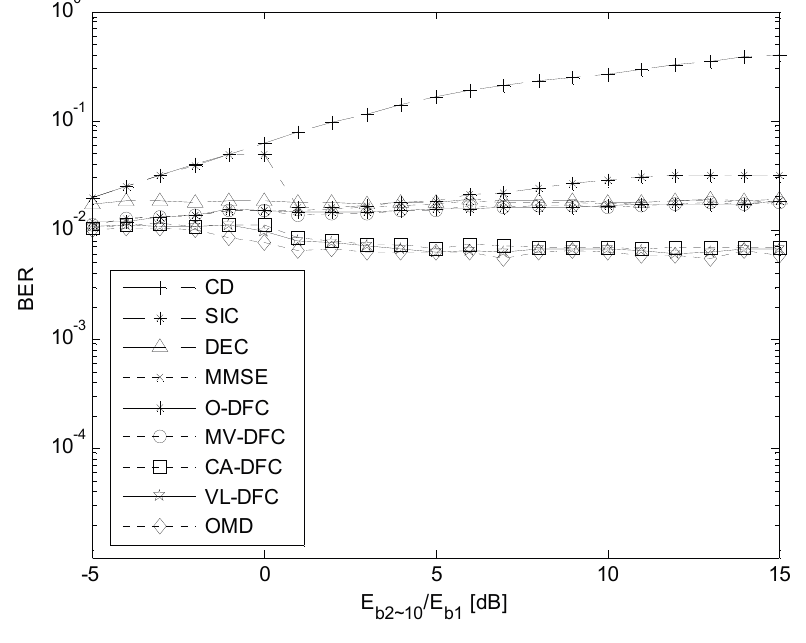
Figure 7. The BER versus E b 2~10 / E b 1 curves in AWGN channel when K = 10 and no power control is